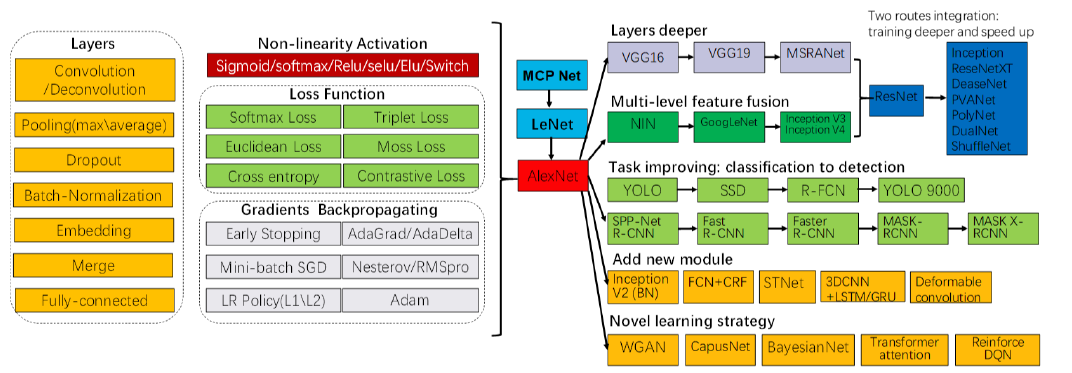
Figure 12. The series of components and structural variants of typical convolutional neural network